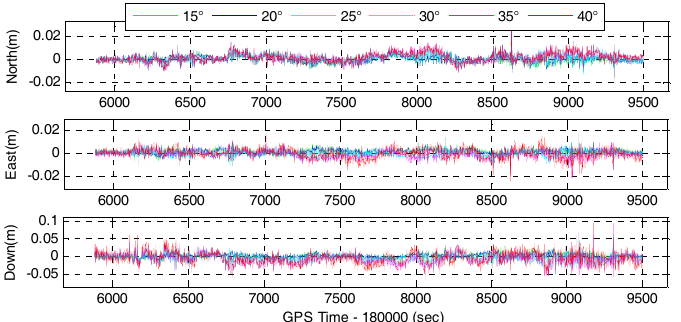
Figure 12. Position difference of GPS/BDS/GLONASS RTK for elevation cut-off angles of 15, 20, 25, 30, 35 and 40°.